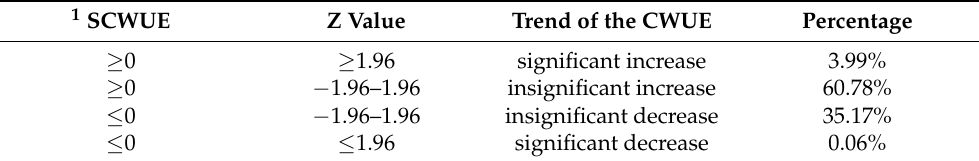
Figure 9. Spatial variation trend of the CWUE in the HHHP. Table 8. Statistics of the cropland water use efficiency (CWUE)